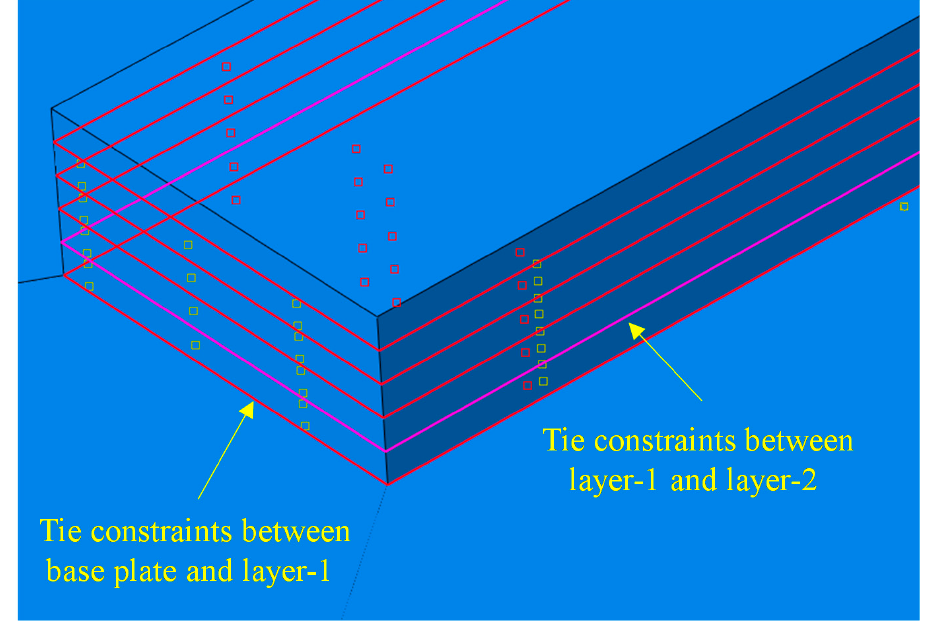
Figure 4. Contact between the base plate material and the powder layers, and between successive layers.